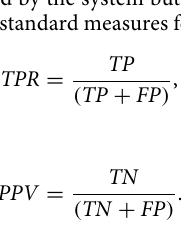
Table 2 contains cross-validation tests with average TP , FP , FN , TPR , PPV and F 1 values for all cases divided into ten groups. Each group contains images obtained from 1 to 2 patients. The average F1 score of the automatic system is 89.13% for kidney detection, which is a satisfactory result. Moreover, another test was performed to evaluate the effect of ROI detection on clustering ability. The results for kidney and spleen detection are shown in Table 3. After implementing the initial ROI detection, a significant improvement in the accuracy of kidney and spleen contour detection is observed. The F1 score increased from 80.57 to 89.30% for kidney detection and from 76.36 to 87.75% for spleen detection. The average time to generate ROI for a case is 2.86 seconds in the tests running on selected kidneys. Figure 16a shows the rectangular ROI in green. Within this ROI we used the organ detection procedure. The contour of the kidney was marked with red color. For the spleen, Fig. 16b, the detected ROI area was colored